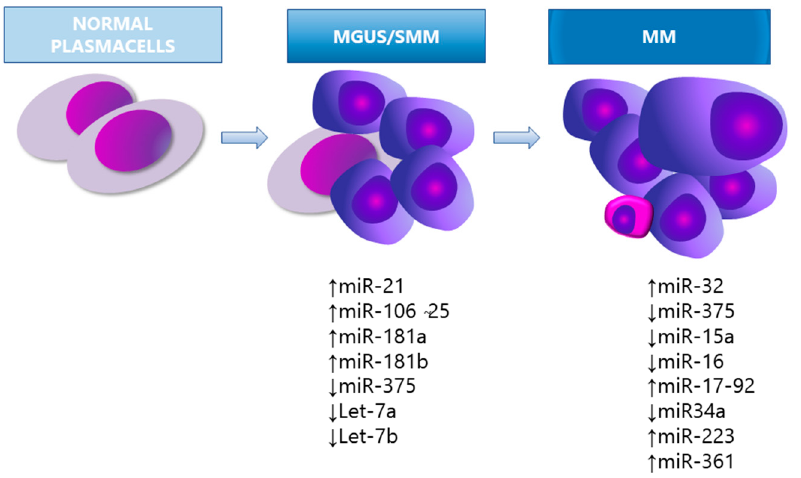
Figure 1. miRNA expression in the pathogenesis of MM. MGUS, monoclonal gammopathy of undetermined significance; SMM, smouldering myeloma.